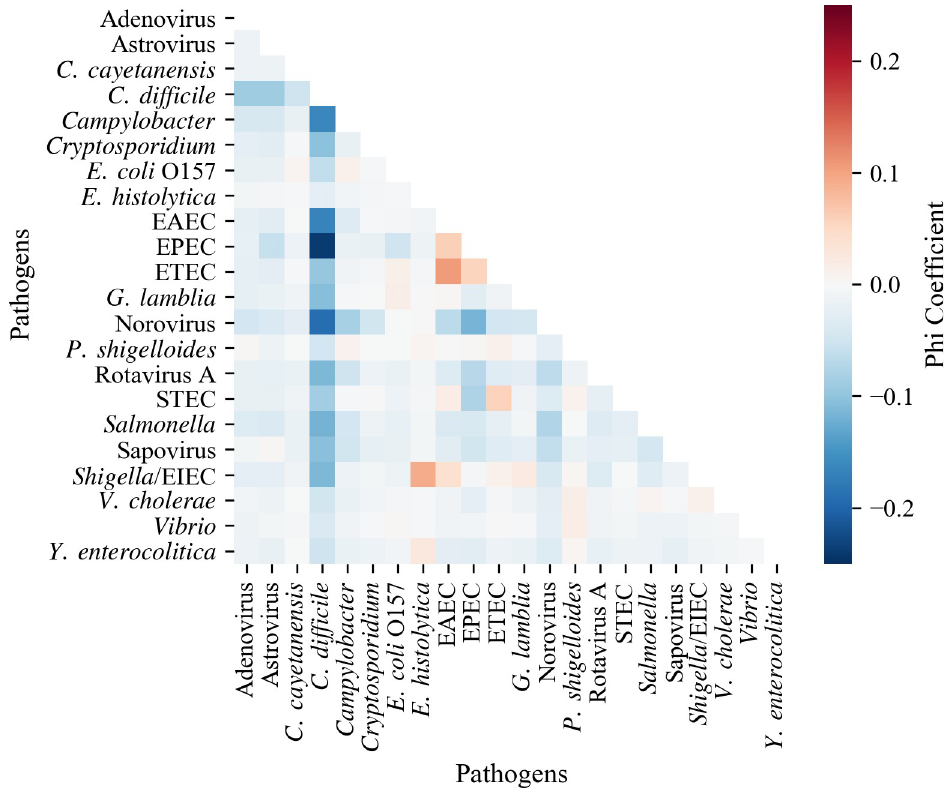
Fig 4. Pathogen correlation for all positive tests with two or more pathogens detected (N = 9,356). (Phi coefficient for each pairwise correlation. Darker red indicates stronger positive correlation between two pathogens, while darker blue indicates negative correlation. The scale range is -0.25 to